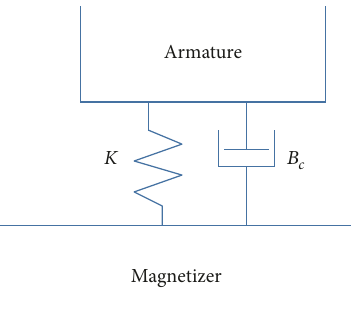
Figure 6: The equivalent physical model of ferrofluid.